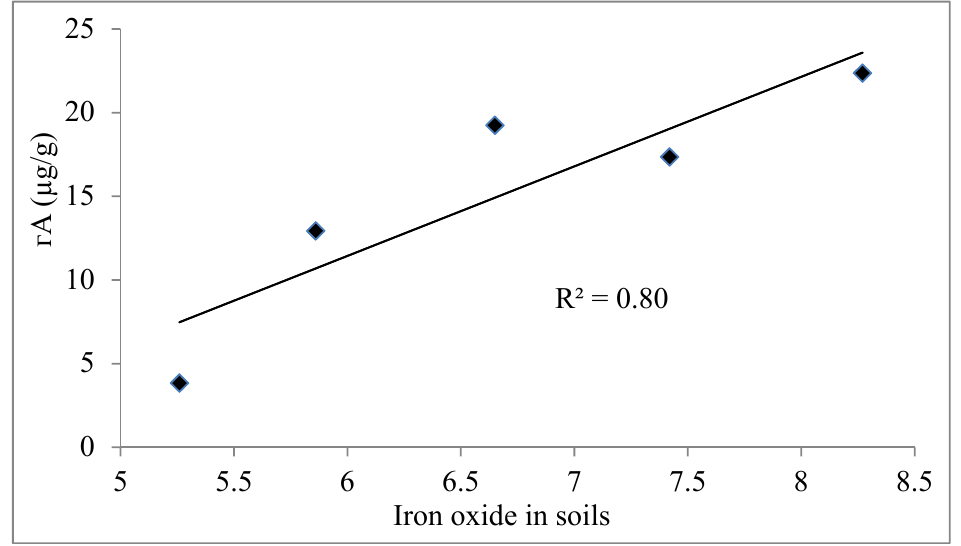
Figure 8. Correlation between the amount of As adsorbed at equilibrium and iron oxide (Fe O ) in 2 3